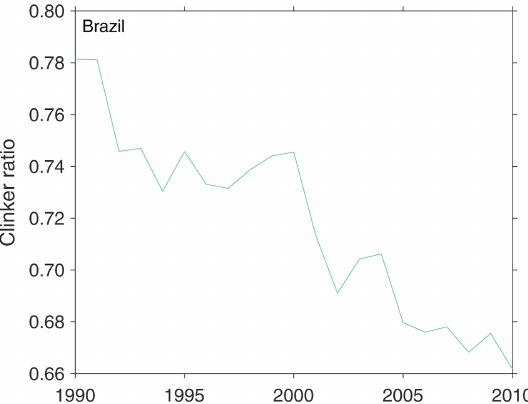
Figure D15. Brazil’s approximate clinker ratio with no account for clinker trade.